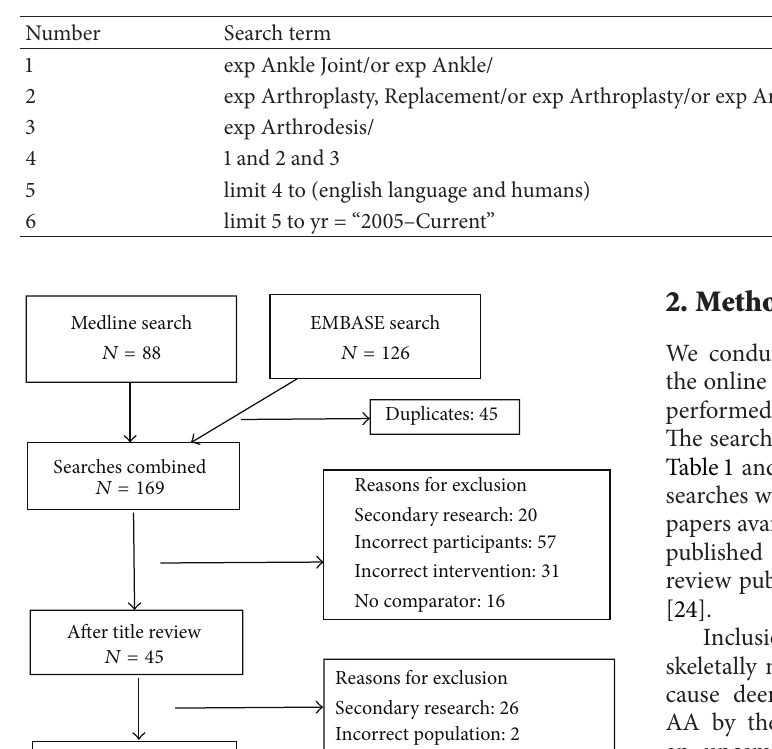
Table 1: Search strategy for Medline.